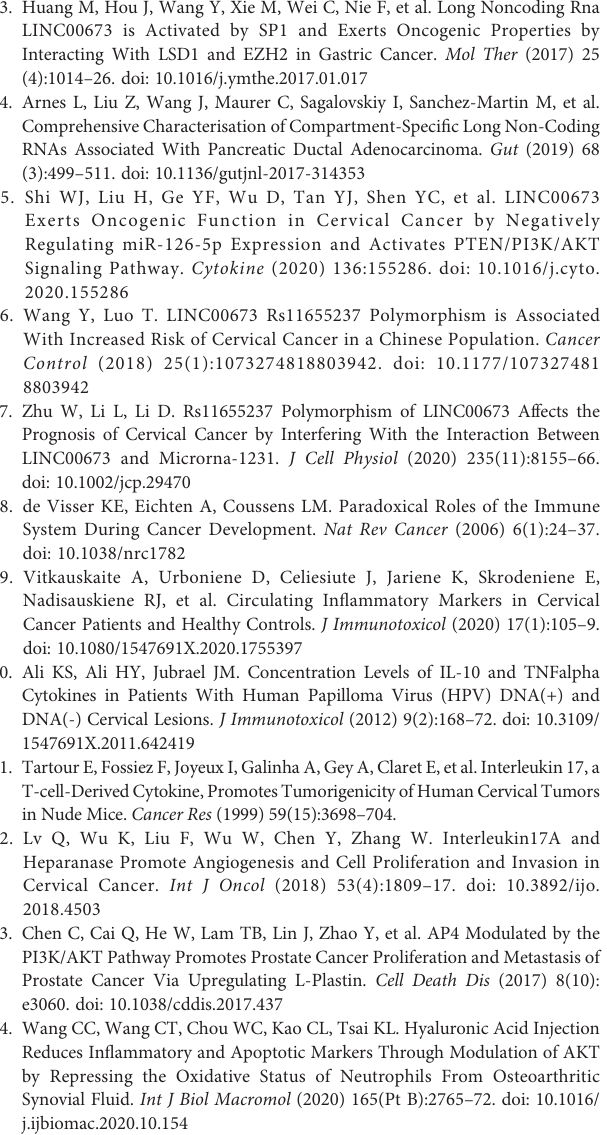
Supplementary Figure 2 | LINC00673 in fl uences the expression of in fl ammatory cytokines. (A, B) RT-qPCR results showed that LINC00673 overexpression did not affect IL-6, IL-10 and Hsp90a mRNA expressions in HeLa (A) and SiHa (B)